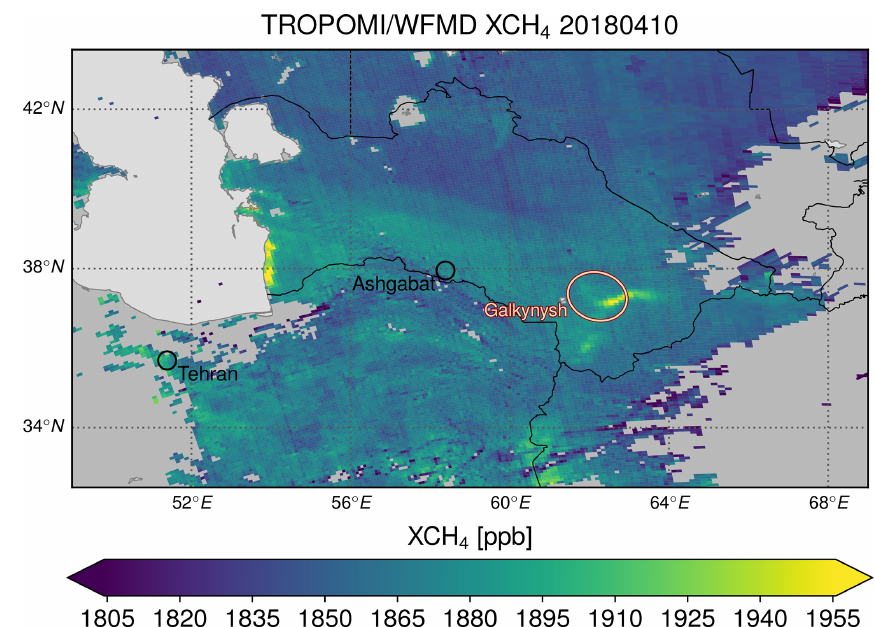
Figure 22. Methane enhancement due to emissions from the world’s second-largest natural gas field, Galkynysh in Turkmenistan.